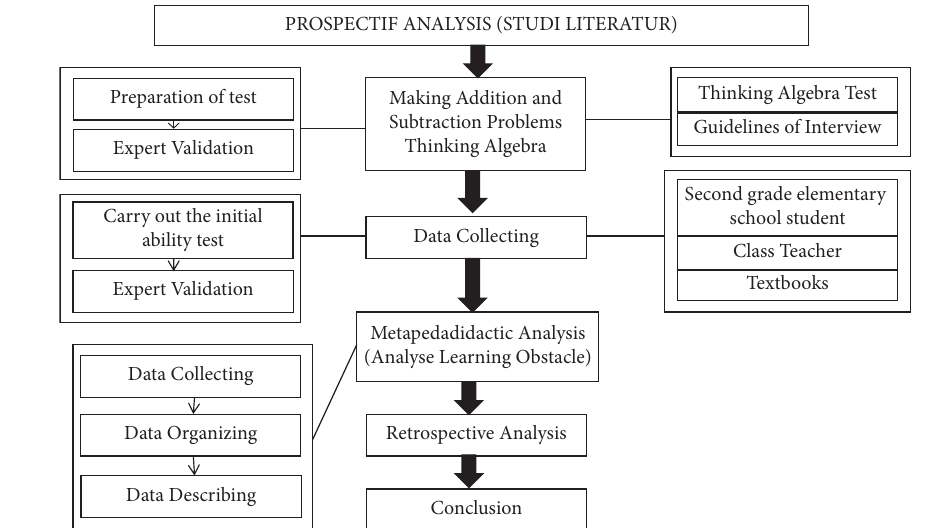
Figure 2: Schema of research implementation Table 1: Algebra thinking addition and subtraction problems.